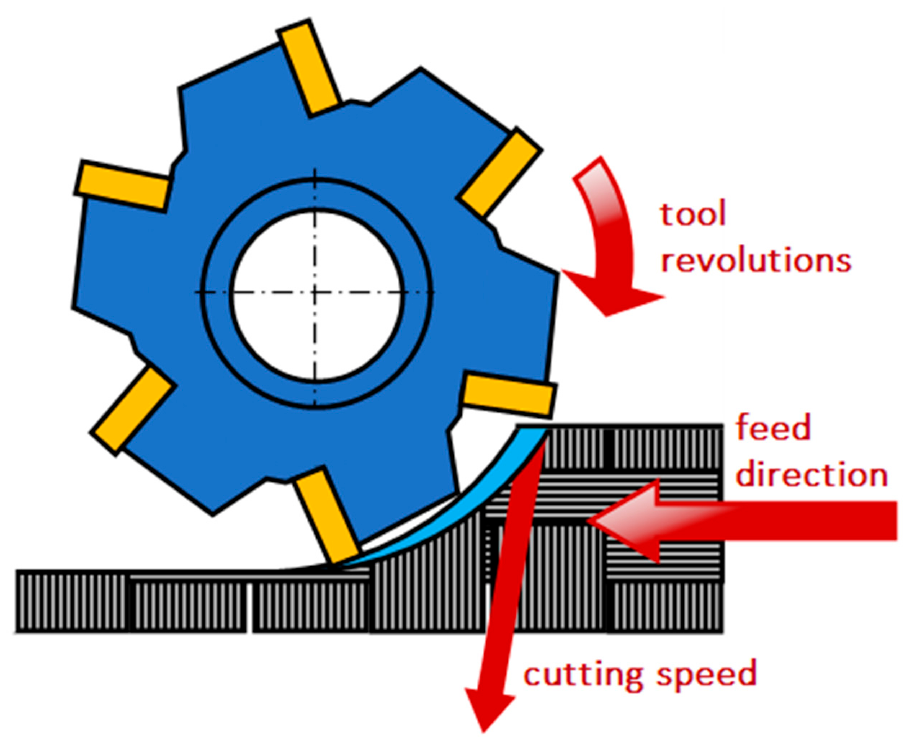
Figure 6. The arrangement of warp and weft yarns from the point of view of delamination during down milling.